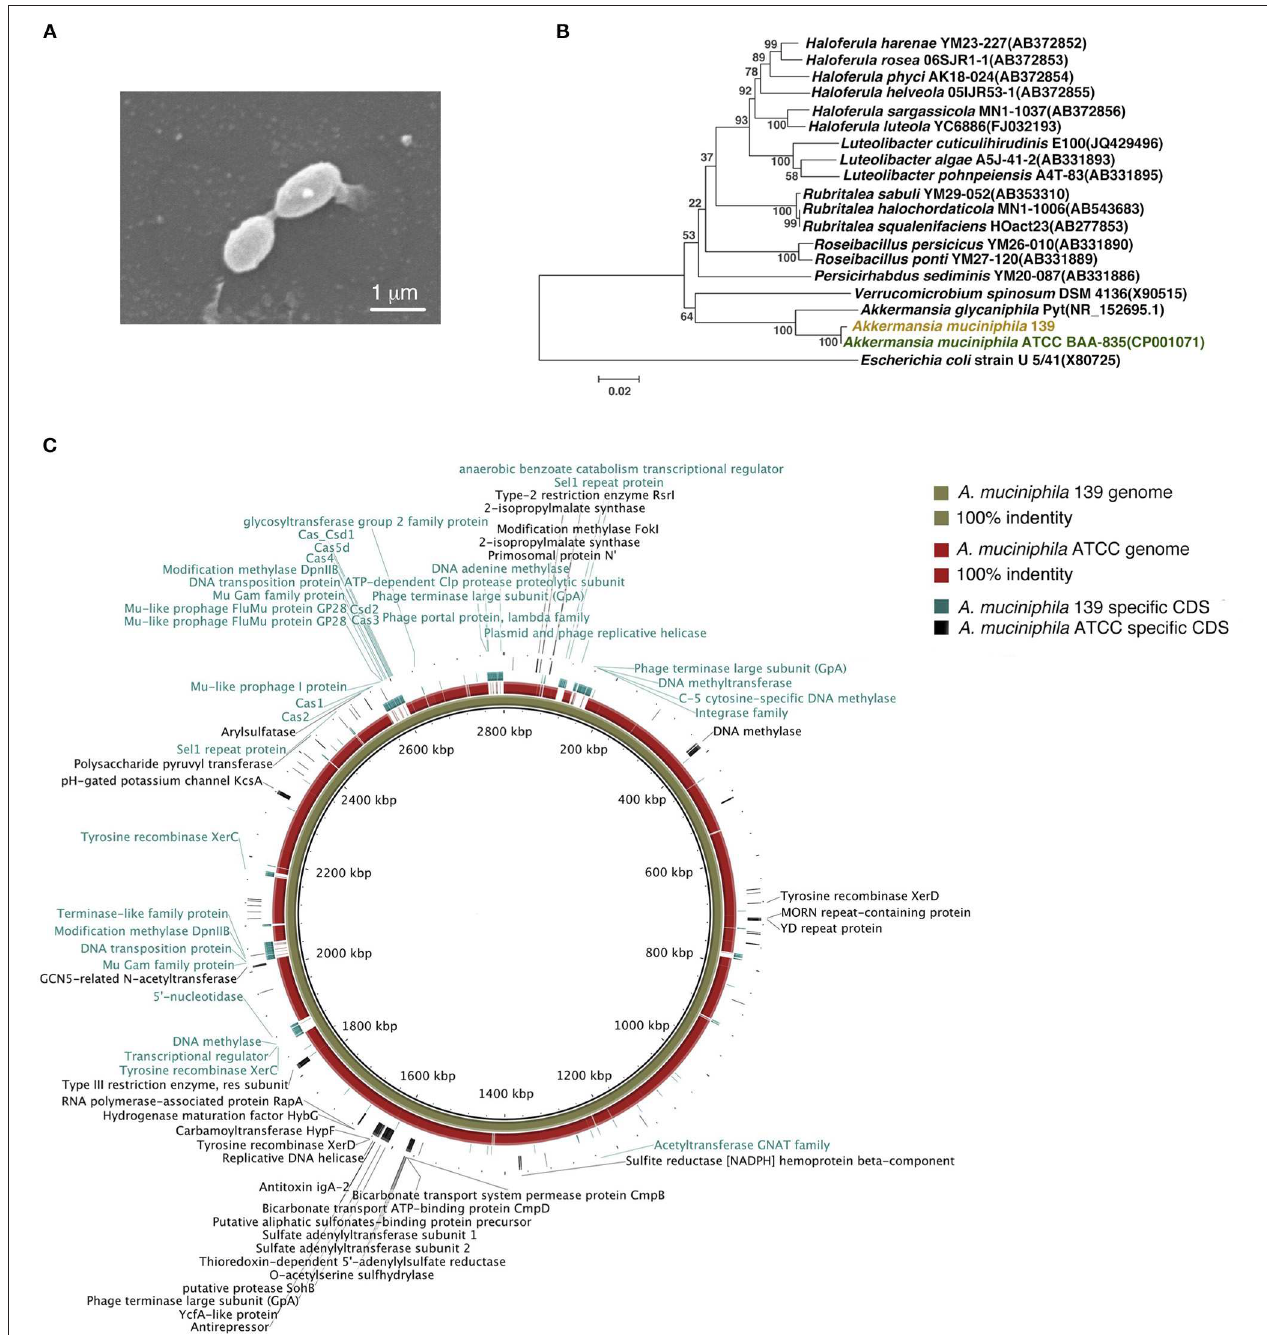
FIGURE 1 | Identification of murine A. muciniphila strain 139 and its genomic comparison with A. muciniphila strain ATCC. (A) Electron micrograph of strain 139. (B) Phylogenetic relationships of the strain 139 with its relatives based on 16S rRNA gene sequences, and Escherichia coli U5/41 was used as an outgroup. The tree was constructed using the Neighbor-Joining method in MEGA6. The bar indicates sequence divergence. (C) Genomic comparison of the chromosomes of A. muciniphila strain ATCC and 139. Both sequences are started from the predicted replication origin. From inner to outer: (1) contig of strain 139, (2) the identity of genome of strain ATCC blast on the strain 139 based on BLASTN, and (3) the strain-specific CDSs of strain 139 and strain-specific CDSs of strain ATCC. The function of the annotated strain-specific CDSs are also